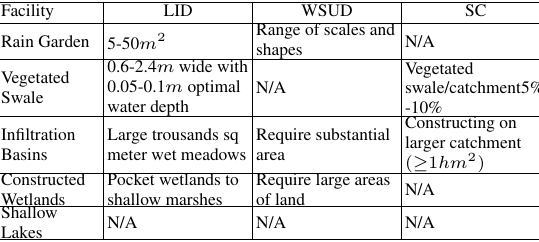
Table 2. Scale and shape of sustainable stormwater